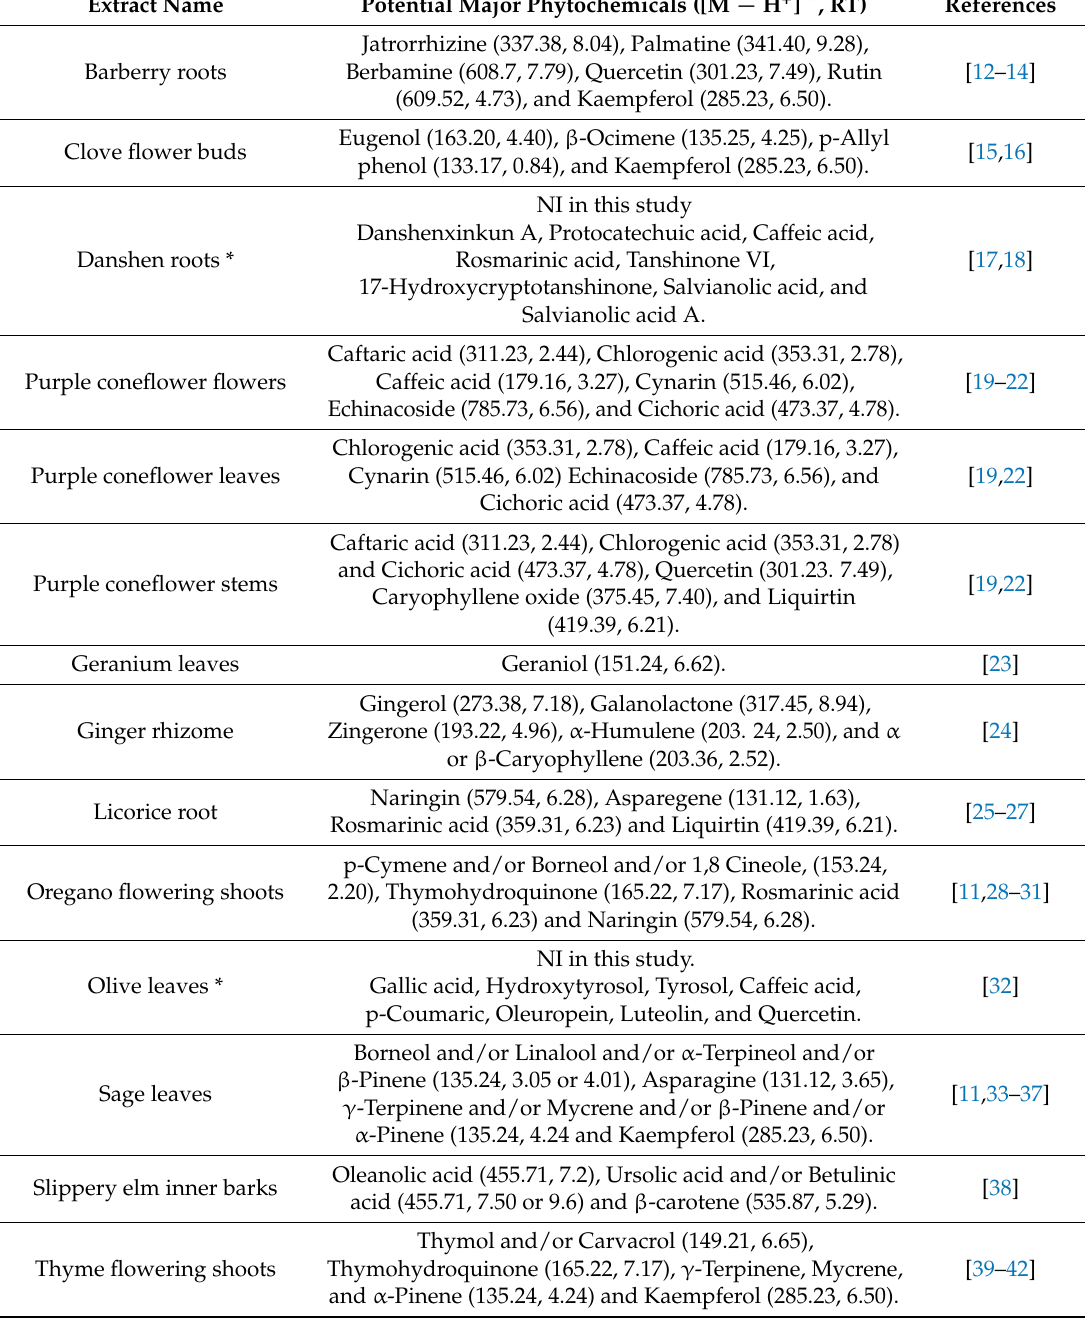
Table 1. Phytochemical profile of the herbal plant parts used in this